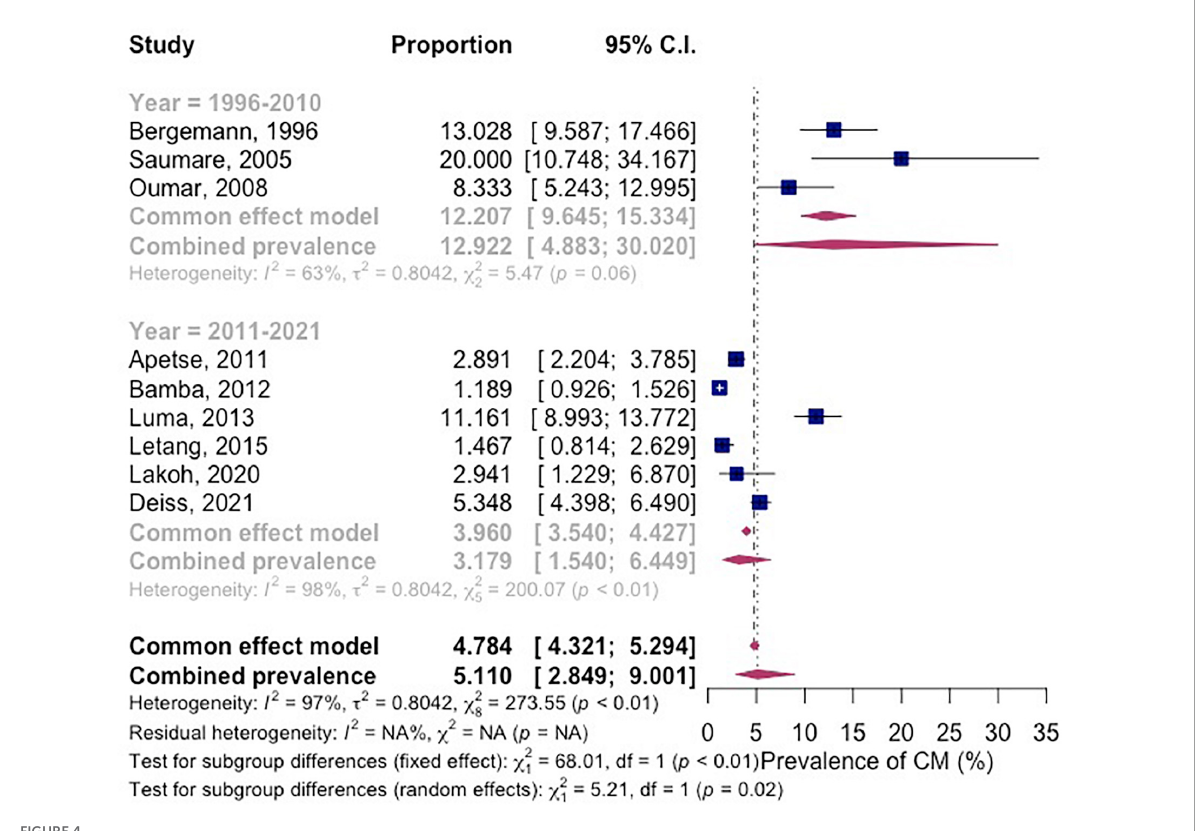
FIGURE4 Forest plot of subgroup analysis by year of the studies were conducted for pooled prevalence in included studies.